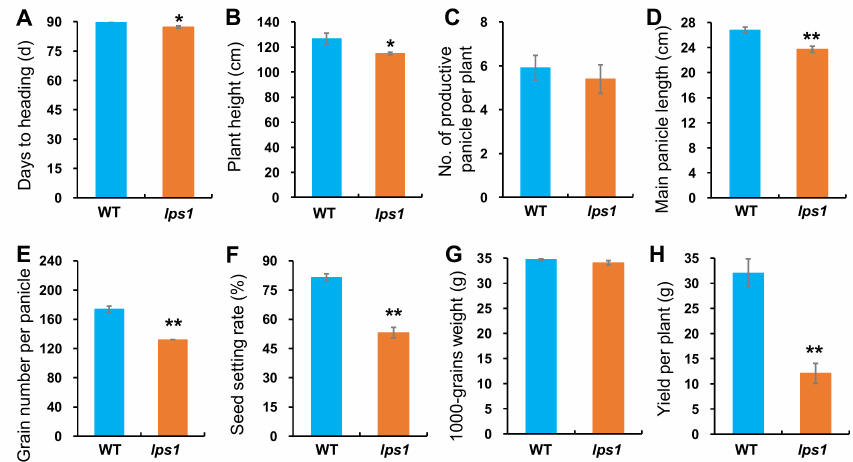
Figure 2. Comparison of major agronomic traits between WT and lps1 . Error bars represent standard deviations of three independent biological replicates. ( A ) Days to heading. ( B ) Plant height. ( C ) Number of productive panicles per plant. ( D ) Main panicle length. ( E ) Grain number per panicle. ( F ) Seed setting rate. ( G ) 1000-grains weight. ( H ) Grain yield per plant. The statistically significant differences were performed by Student’s t test. * p < 0.05 and ** p < 0.01.